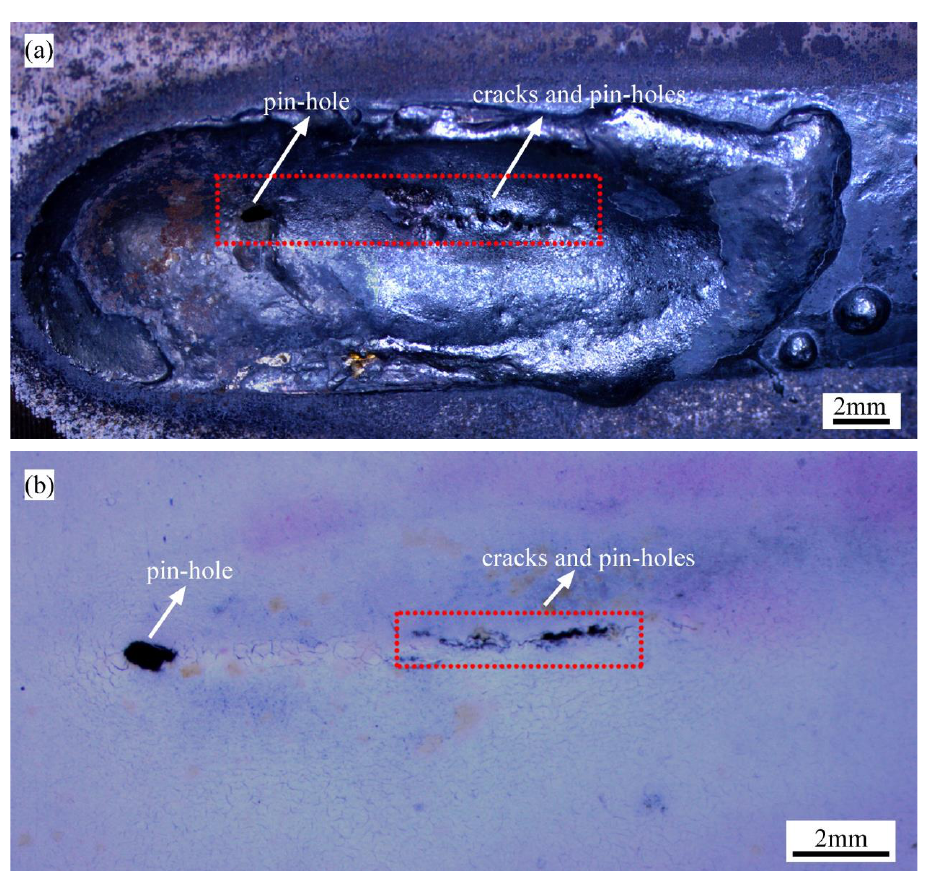
Figure 12. Macroscopic morphology near the burn-through zone of 17-ZD-11: ( a ) upside; ( b ) backside.